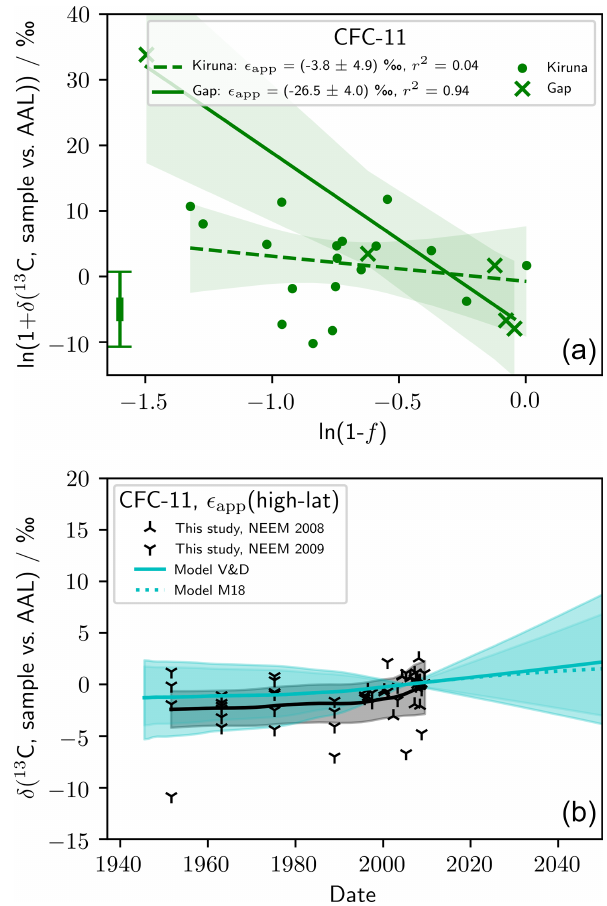
Figure D1. (a) Rayleigh plot showing observations of δ 13 (C, CFC- 11) and derived (cid:15) app (CFC-11, high-latitude) and (cid:15) app (CFC-11, mid-latitude). (b) Also shown is measured and modelled δ T (CFC- 11) (see Fig. 4 and Sect. 2.5 for a description of the model). The model was forced with (cid:15) app (CFC-11, high-latitude). The error bar in the bottom left corner of (a) shows the median repeatability of the reference gas measurements over the measurement days and the median error deriving from the fractional release